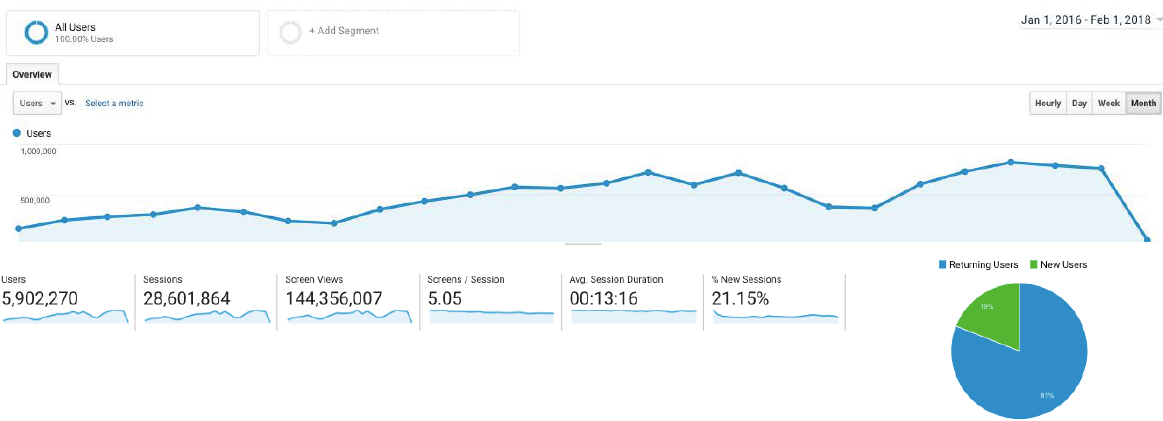
Figure 4. This image shows the Google Analytics